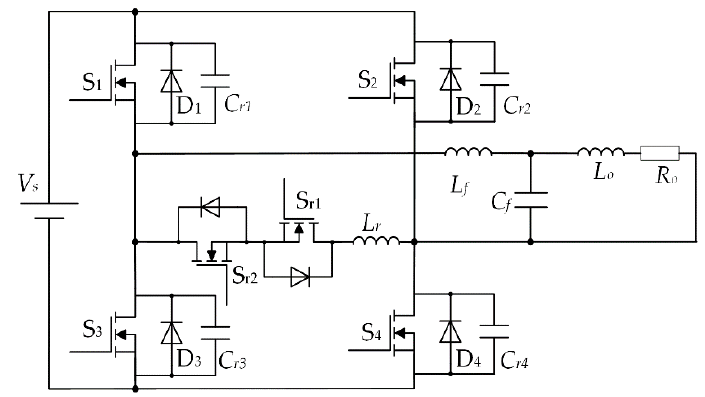
Figure 1. Circuit of the single ‐ phase auxiliary resonant snubber inverter (ARSI) with LC filter.